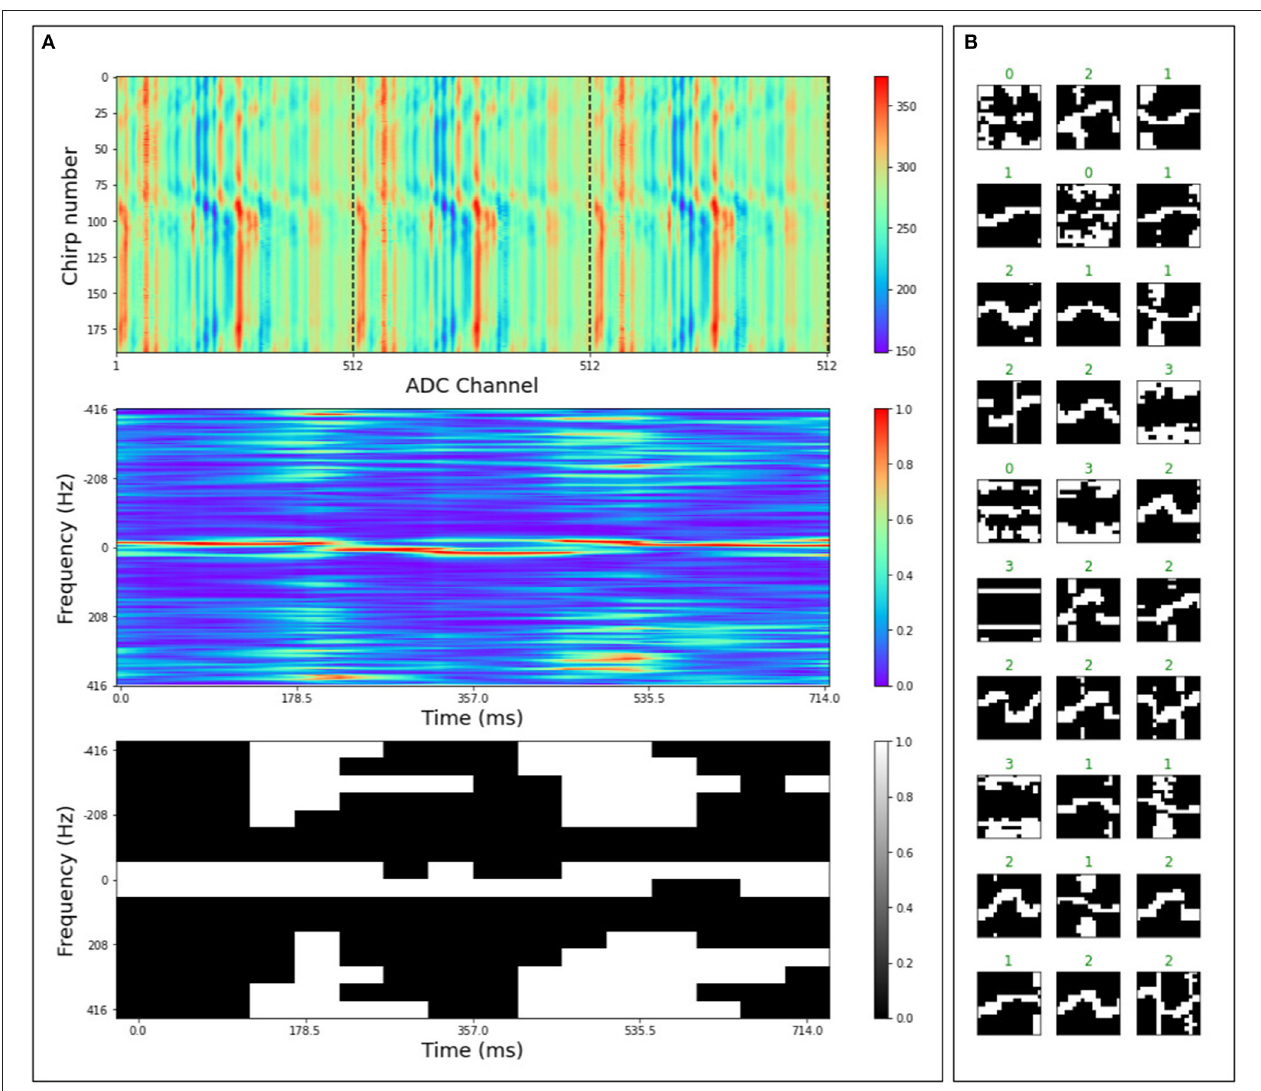
FIGURE 9 | (A) Shows the preprocessing of the radar signal for 3 frames of raw ADC data ( A top), to a micro-Doppler map ( A middle), to a thresholded, scaled (16 × 16), and binarized version of the micro-Doppler map ( A bottom). The binary image gets converted into a spike stream for the µ Brain chip. (B) Shows examples from the preprocessed radar gesture dataset in which the label at the top associates to its respective gesture as 0: hello, 1: toward, 2: horizontal, 3: background.